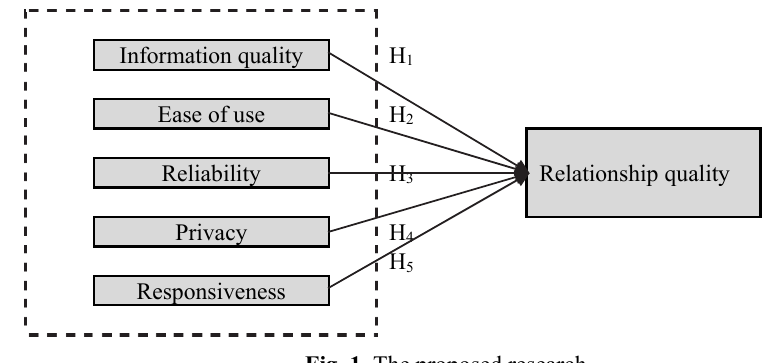
Fig. 1. The proposed